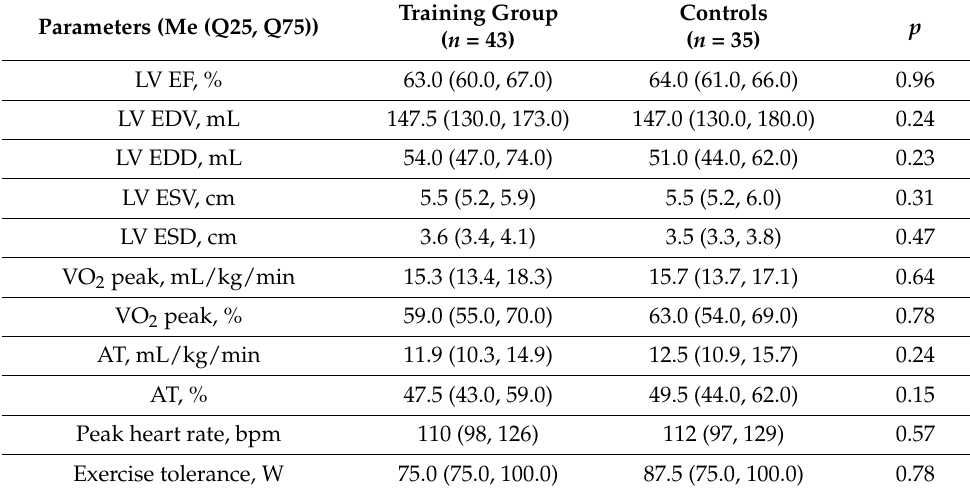
Table 2. Echocardiography and cardiopulmonary exercise test results for the patients according to the approach to prehabilitation.